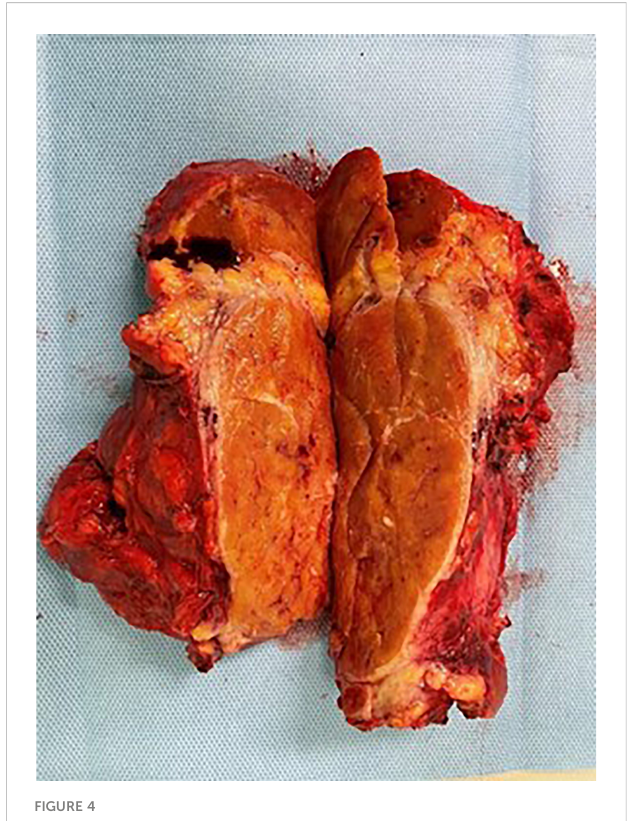
FIGURE 5 Unicentric CD in the retroperitoneal space between the aorta and inferior vena cava.